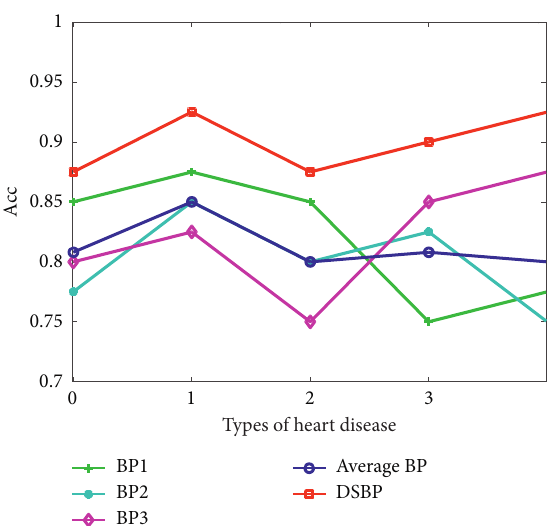
Figure 10: The trend graph BP and DSBP prediction accuracy rate with threshold change.